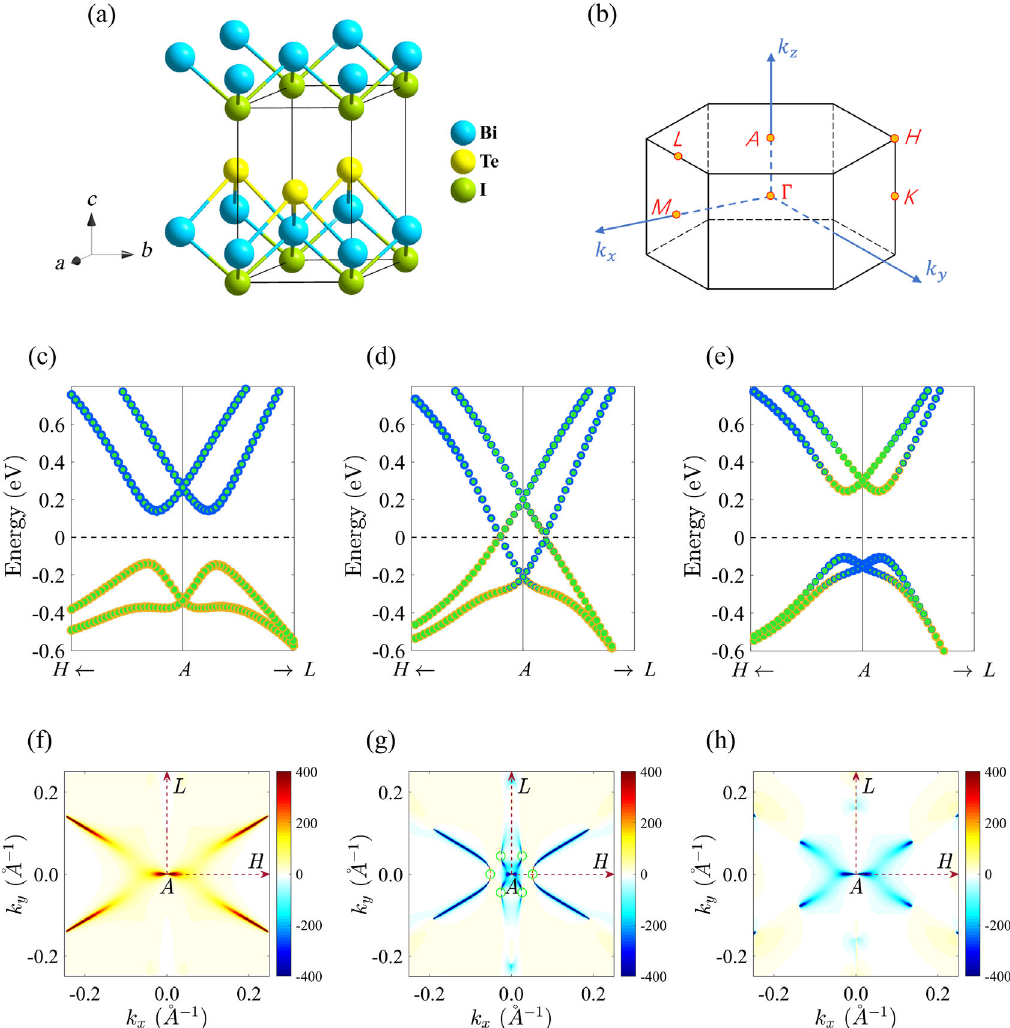
FIG. 6. (a) Layered crystal structure of BiTeI and its primitive cell (black frame). (b) Corresponding Brillouin zone. The effects of changing the lattice constants that start from a ¼ 4 . 42 Å (c,f), to a ¼ 4 . 22 Å (d,g), and to a ¼ 4 . 02 Å (e,h). The band gap undergoes the process of closing and reopening around the A point. The orbital compositions reverse near the minimum band gap (c) – (e), where the blue, yellow, and green dots represent the weight from Bi- 6 p , Te- 5 p , and I- 5 p atomic orbits in the Bloch wave functions, respectively. The black dashed line represents the Fermi energy. In panels (f) – (h), as the band inversion occurs, the shift vector simultaneously reverses, which starts at the points where the band gap closes. In panel (g), the six, small green circles mark three pairs of Weyl points along the A - H direction where the band gap closing